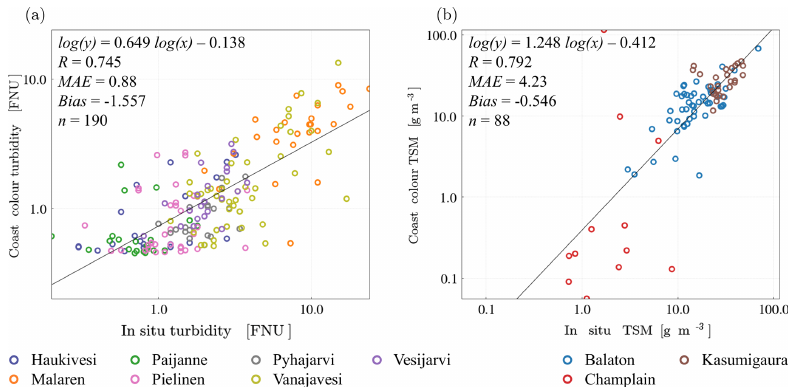
Figure 10. Turbidity (a) and TSM (b) matchup scatter plots and statistics across different lakes. Note that only turbidity data in units FNU were